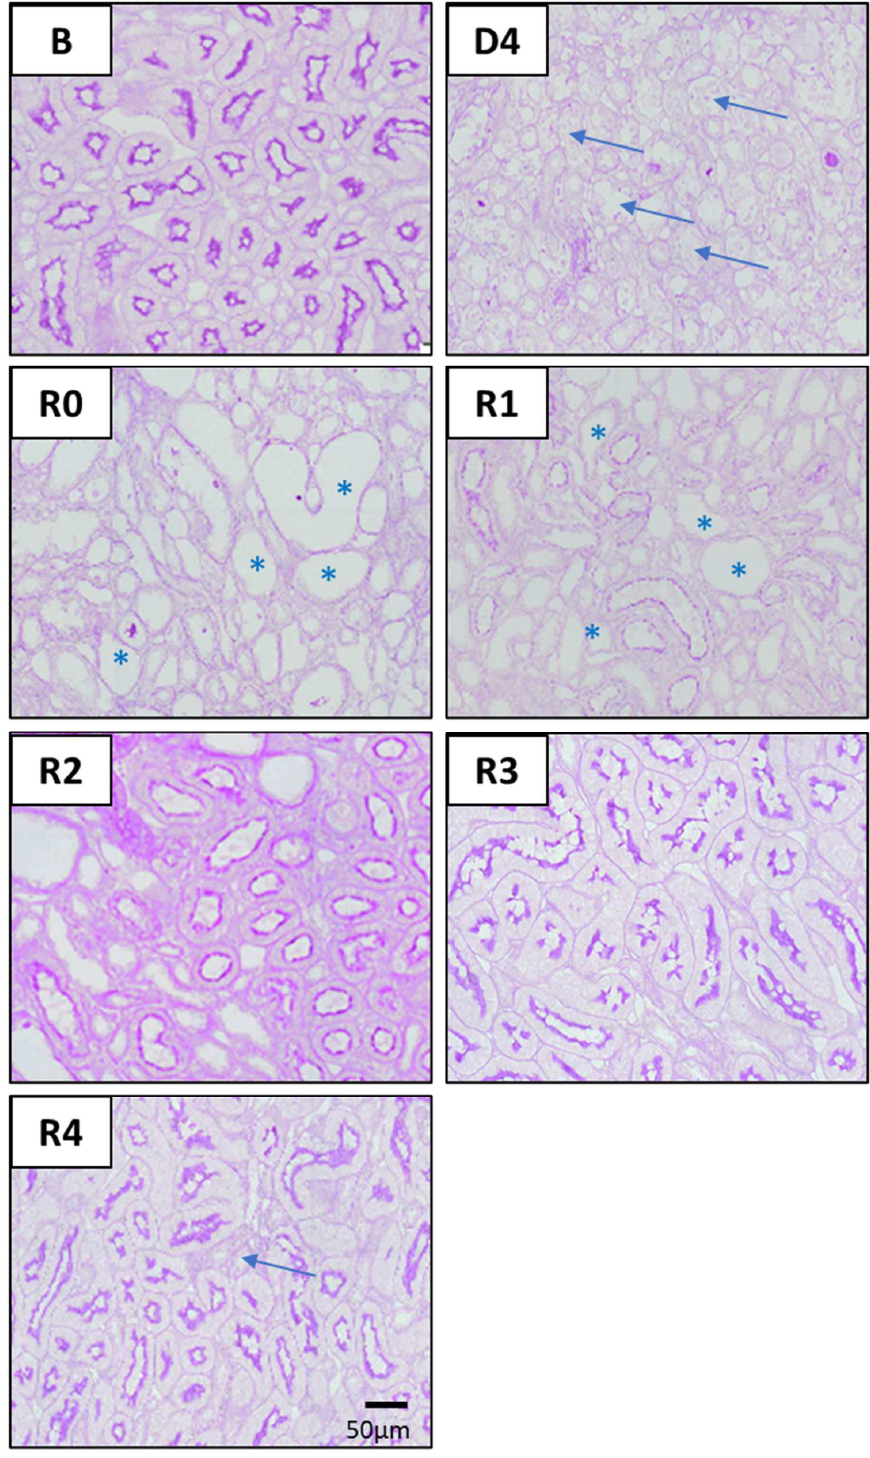
Figure 4. Renal histology. Representative images of kidney specimens stained with periodic acid– Schiff (PAS) at different time points of AKI evolution. ( B ): basal; ( D4 ): day of maximum kidney damage after cisplatin treatment; ( R0 ): day of recovery; ( R1 ): 1 week after recovery; ( R2 ): 2 weeks after recovery; ( R3 ): 3 weeks after recovery; ( R4 ): 4 weeks after recovery. Arrows in D4 indicate widespread detachment of necrotic tubular epithelial cells. Asterisks in ( R0 ) and ( R1 ) indicate dilated proximal tubules with loss of the brush border. Arrow in R4 indicates an area with interstitial fibrosis and tubular